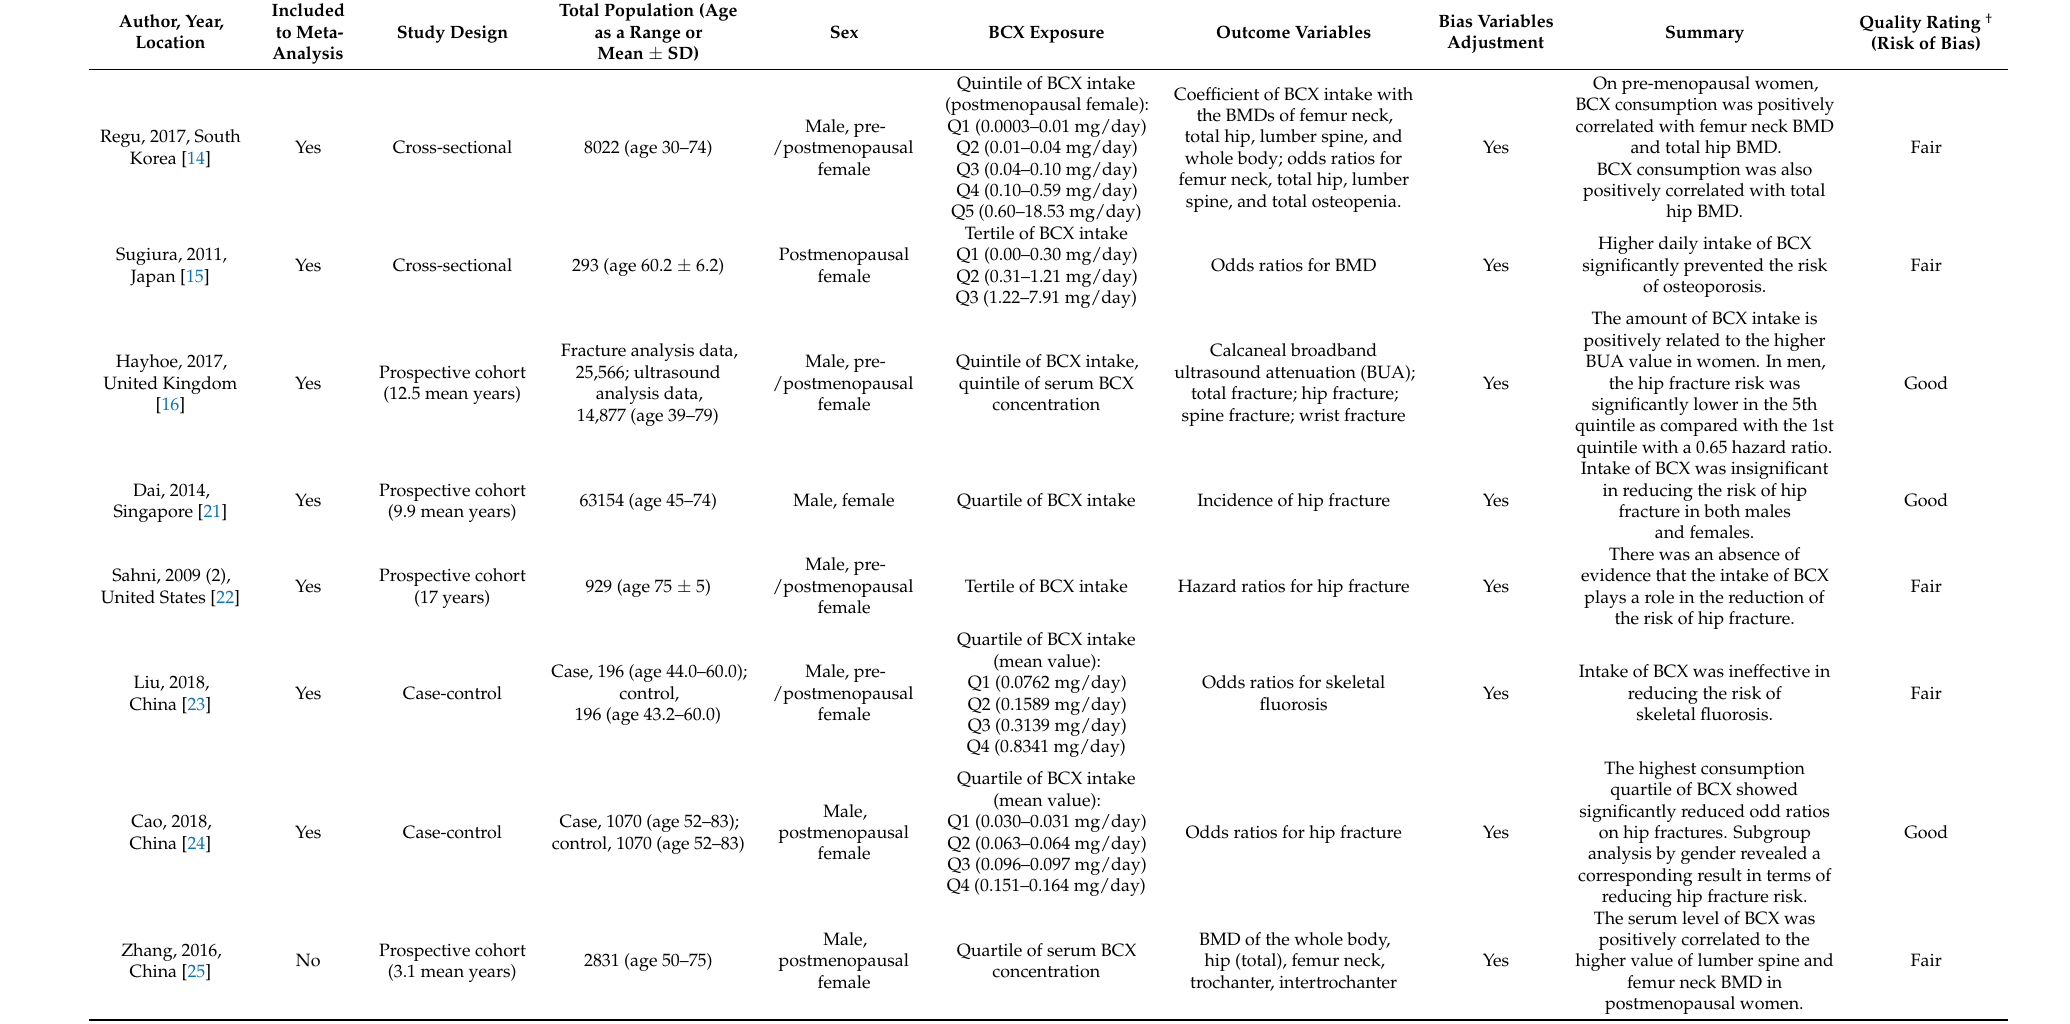
Table 1. Demographic characteristics, evaluation parameters, and outcomes of 15 observational